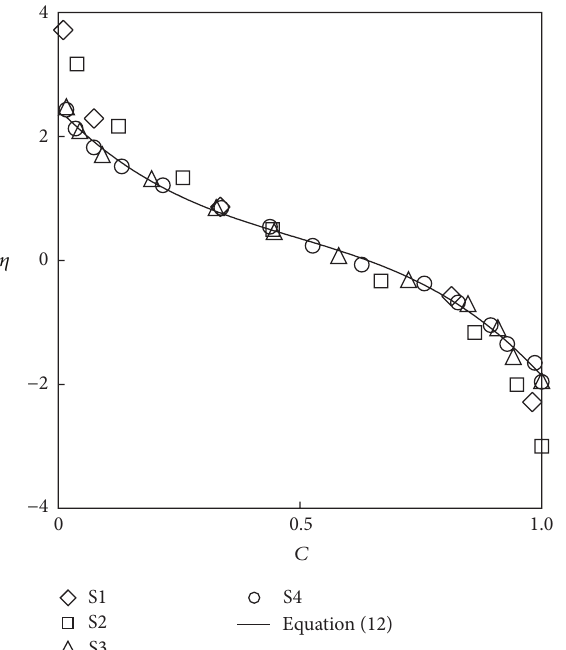
Figure 10: Similarity of 𝐶 distribution at